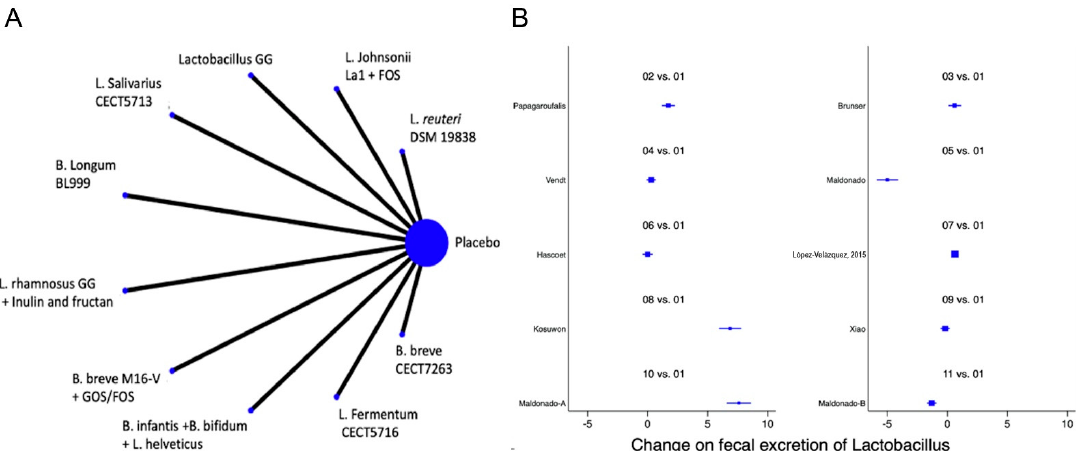
Figure 7. Network meta-analysis for probiotics and change on faecal Lactobacillus . ( A ) Network diagram: the area of the blue nodes is based on the total number of patients for each respective interventions; ( B ) forest plot of multiple treatments.